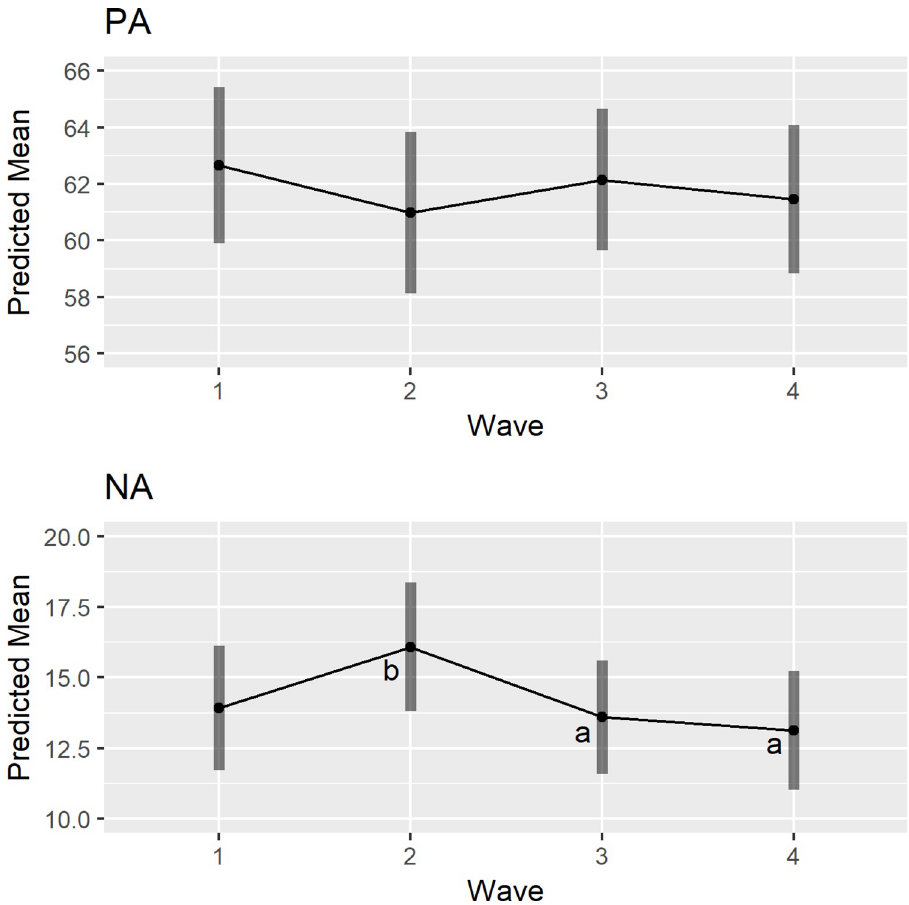
Fig 2. The predicted means of momentary PA and NA across waves. Note . For models with a significant overall effect of wave, different letters indicate that the predicted means in those waves were significantly different from each